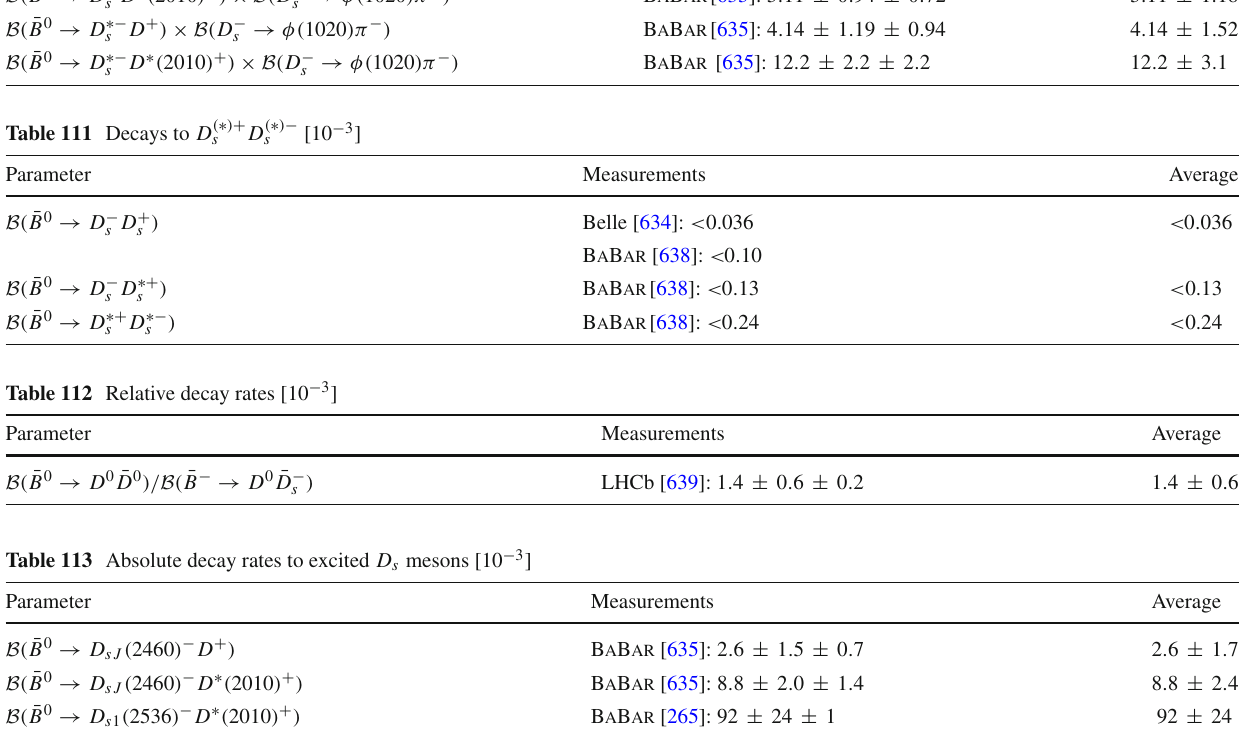
Table 110 Decays to D